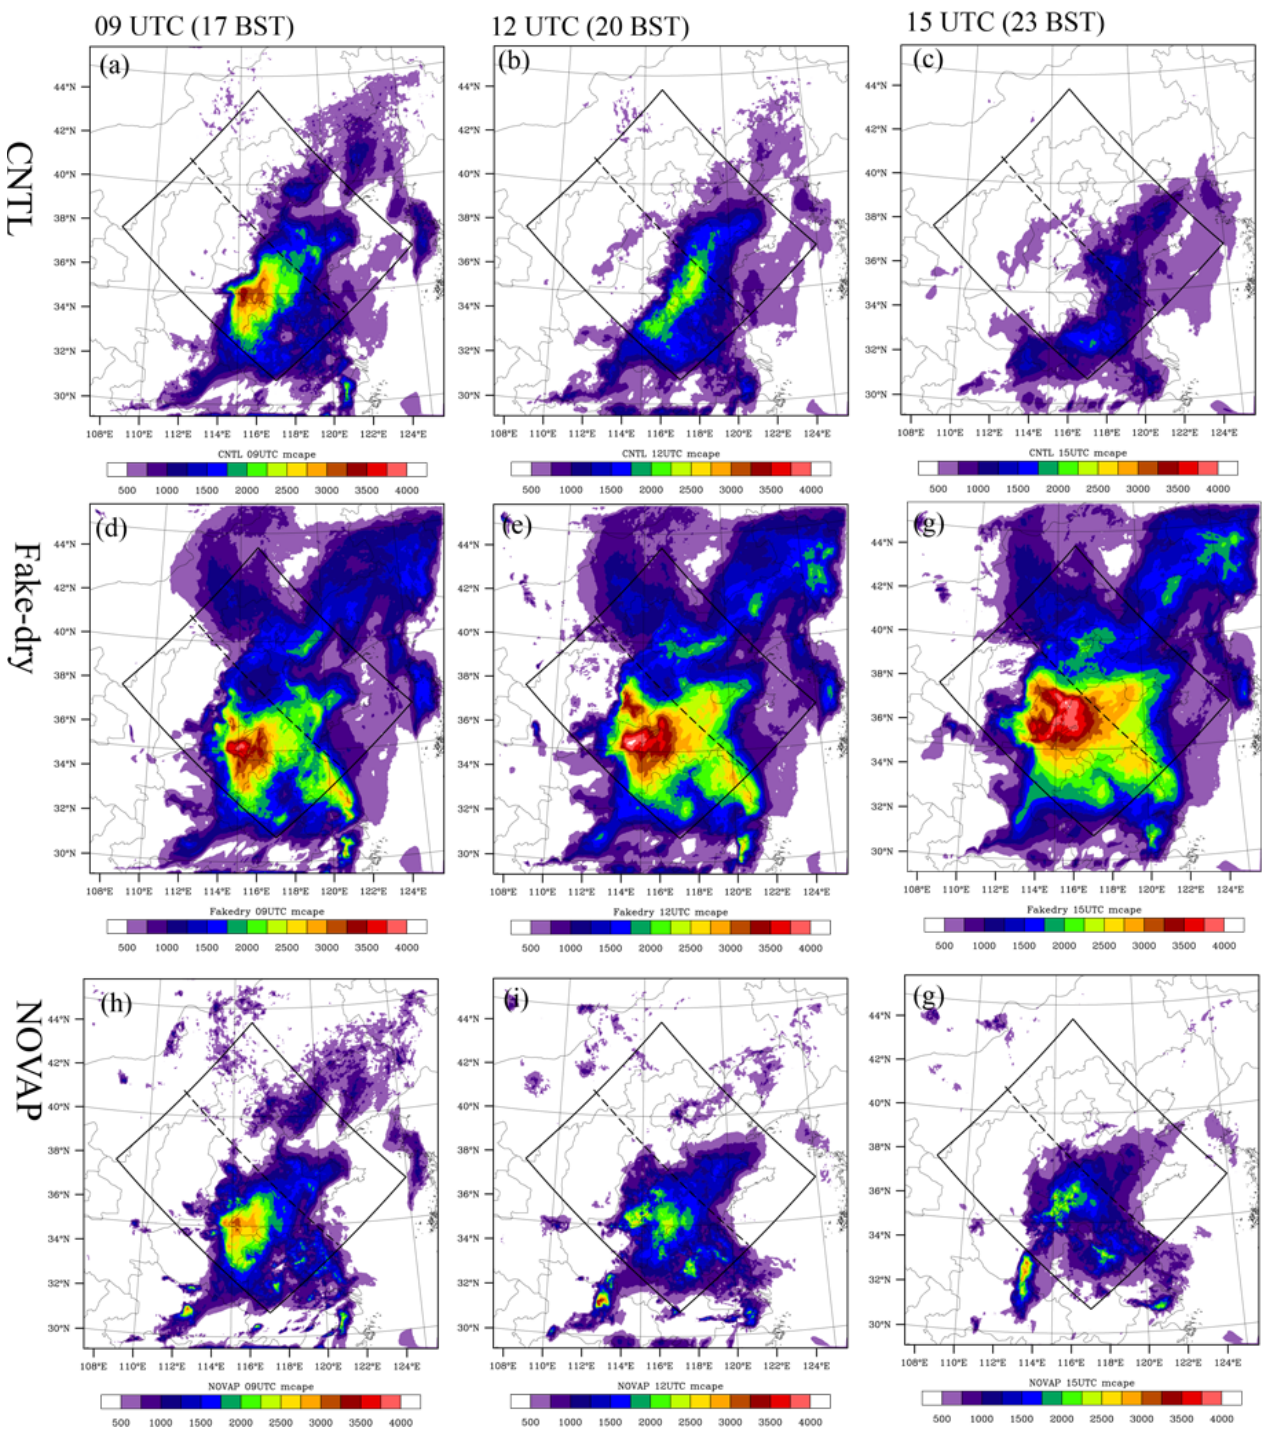
Fig. 12. The distribution of the averaged CAPE (JKg − 1 ) at 09:00UTC, 12:00UTC, and 15:00UTC in CNTL (a–c) , Fake-dry (d–f) , and NOVAP (h–g)